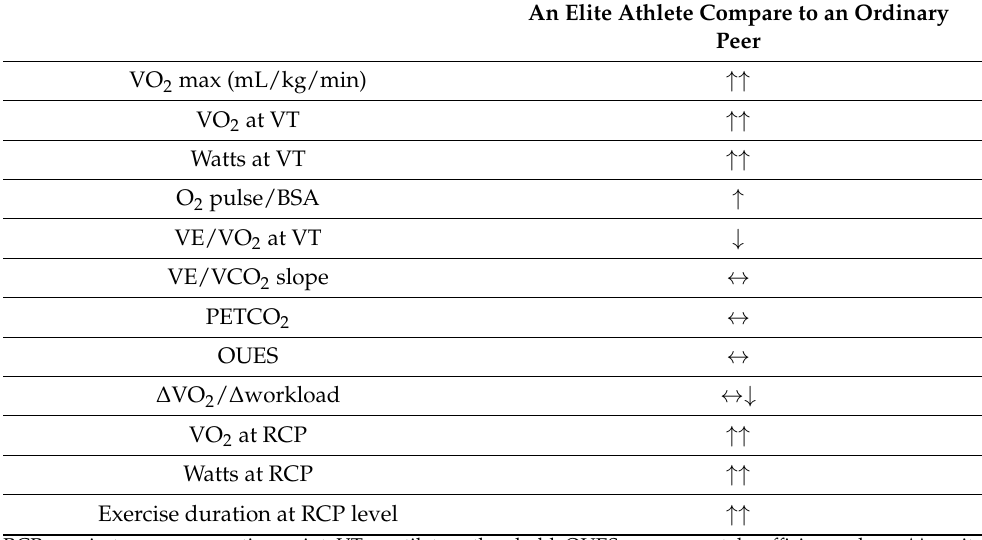
Table 2. Key CPET parameters in elite